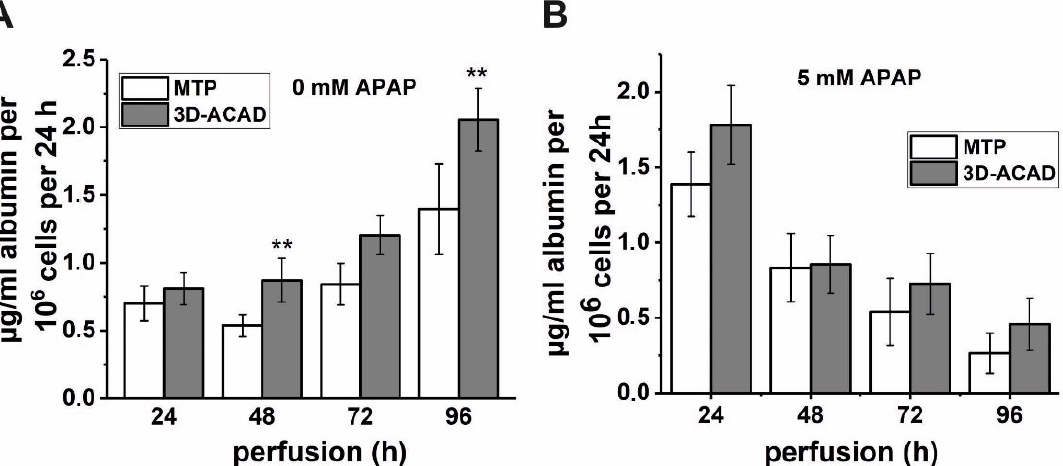
Figure 5. Comparison of albumin concentrations in medium supernatants without ( A ) and with ( B ) 5 mM APAP perfusion quantified with 3D-ACAD or with an ELISA quantification kit (MTP). The mean values ± SE are shown; n = 3 experiments; ** p < 0.01.